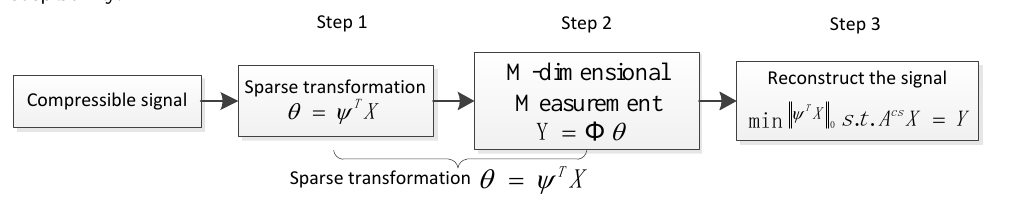
Figure 1 The flow chart of Compressive